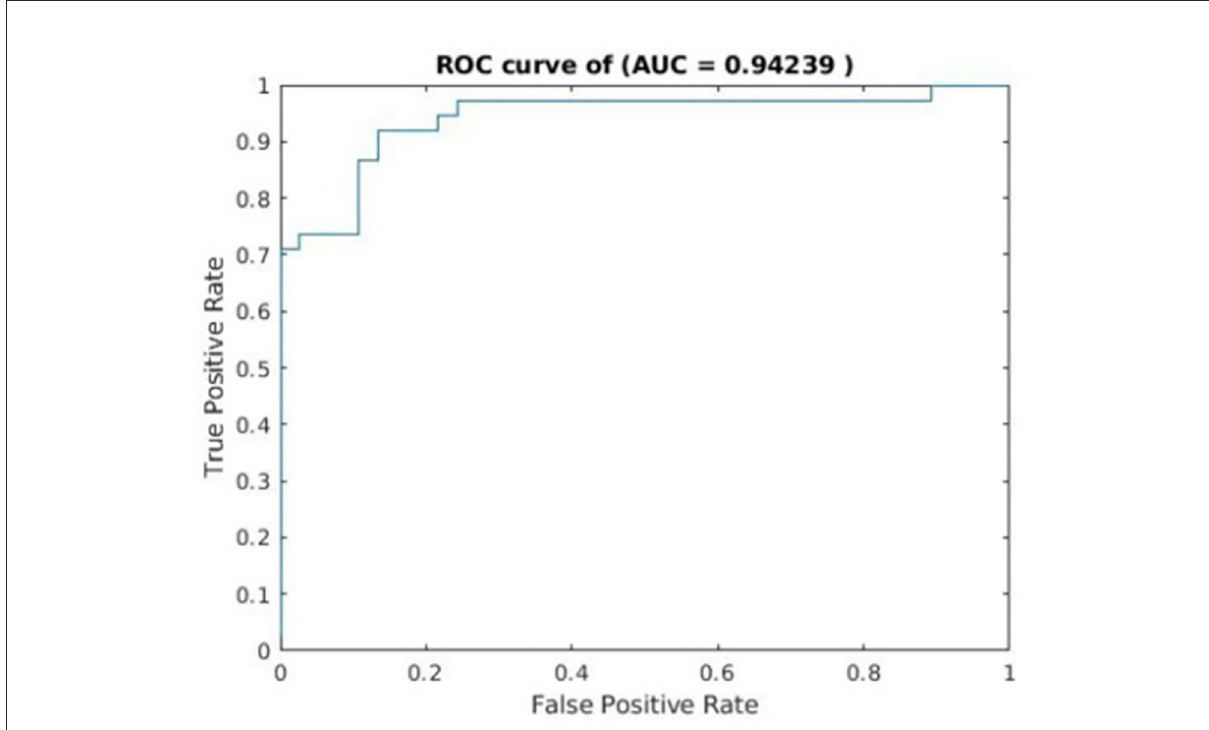
FIGURE3 Receiver operating characteristics curves for cross-validated prediction performance of classifiers trained on resting-state functional magnetic resonance imaging (rs-fMRI)